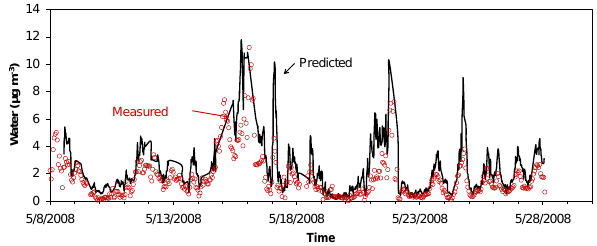
Fig. 7. Water versus time as calculated from E-AIM and measured by the DAASS at close to ambient RH. The water uptake by the organics is neglected in the predicted water concentration.